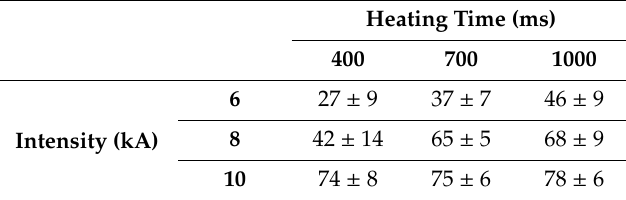
Table3. Meanvaluesandstandarddeviationsofmicrohardness(HV1)forthedifferentMF-ERScompacts.